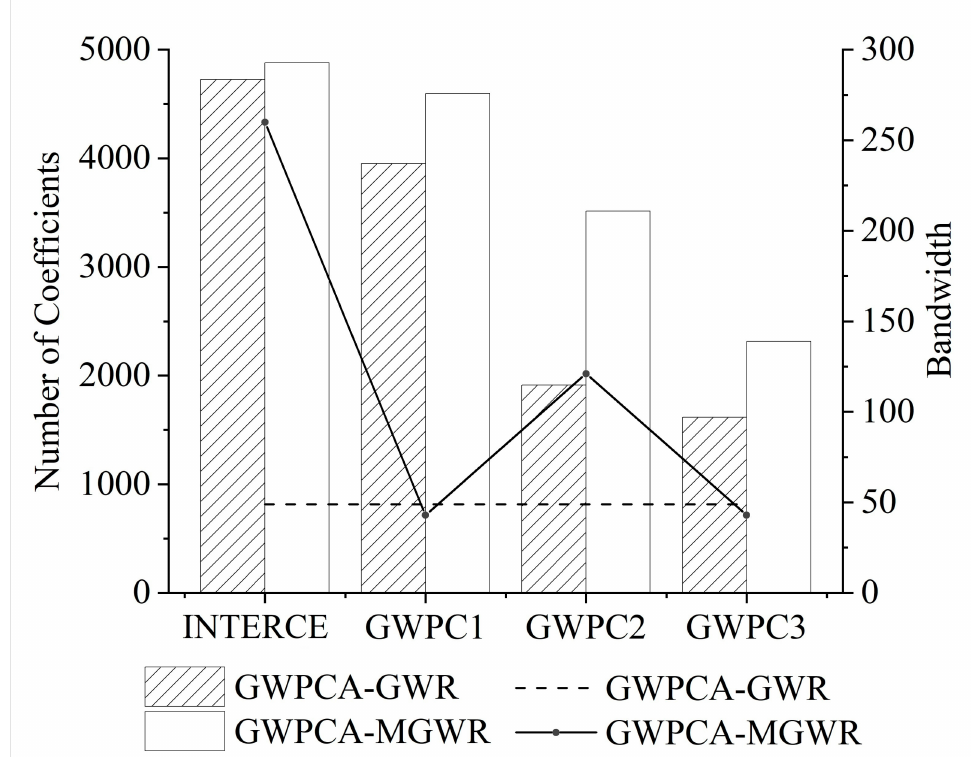
Figure 6. Optimal bandwidths and number of coefficients generated by GWPCA-GWR and